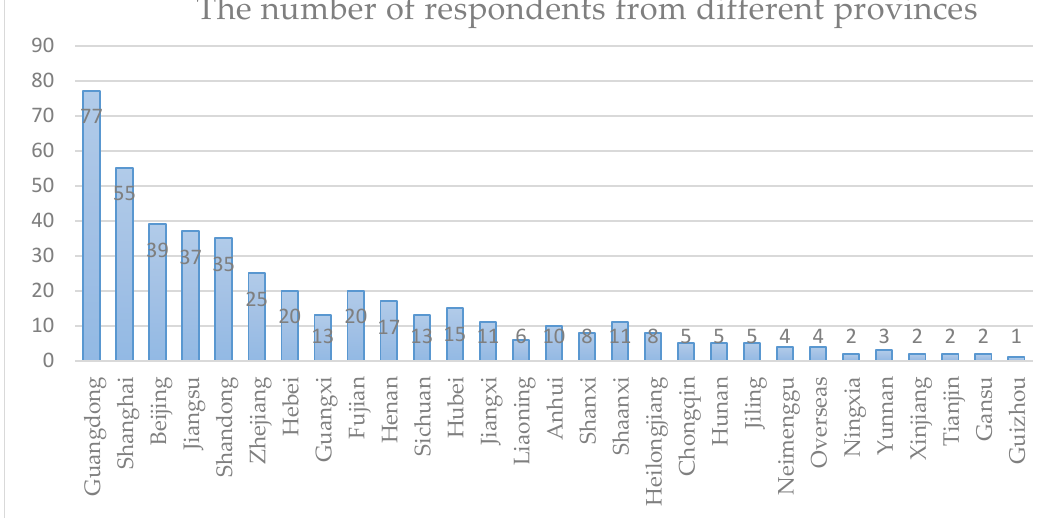
Figure 3. Reports the number of respondents from different provinces in China. Note: This bar chart displays the number of observations by provinces. The x -axis lists the names of the provinces, while the y -axis lists the number of respondents from each province.